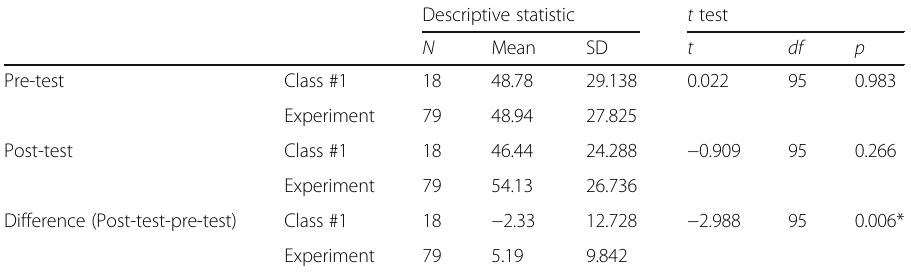
Table 16 Independent t test result for students ’ academic achievements between class #1 and the experiment group